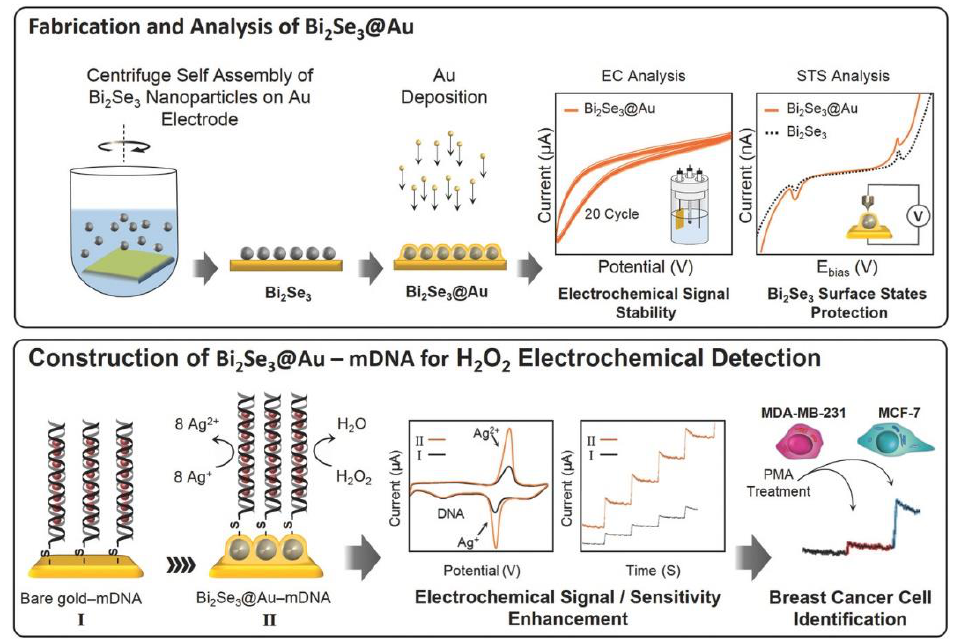
Figure13. SchematicforstepwisefabricationandanalysisofBi 2 Se 3 @Auelectrodeaswellasconstruction and performance of Bi 2 Se 3 @Au-metallic DNA biosensor toward profiling two breast cancer cells based on their H 2 O 2 abundance. Reproduced with permission from